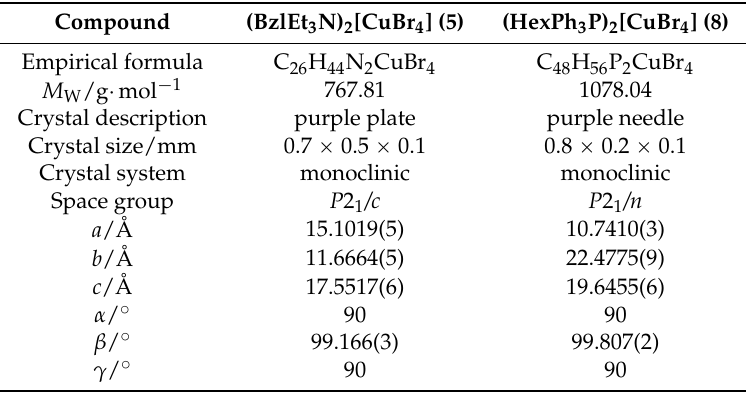
Table 1. Crystallographic data and refinement parameters for ( 5 ) and ( 8 ).